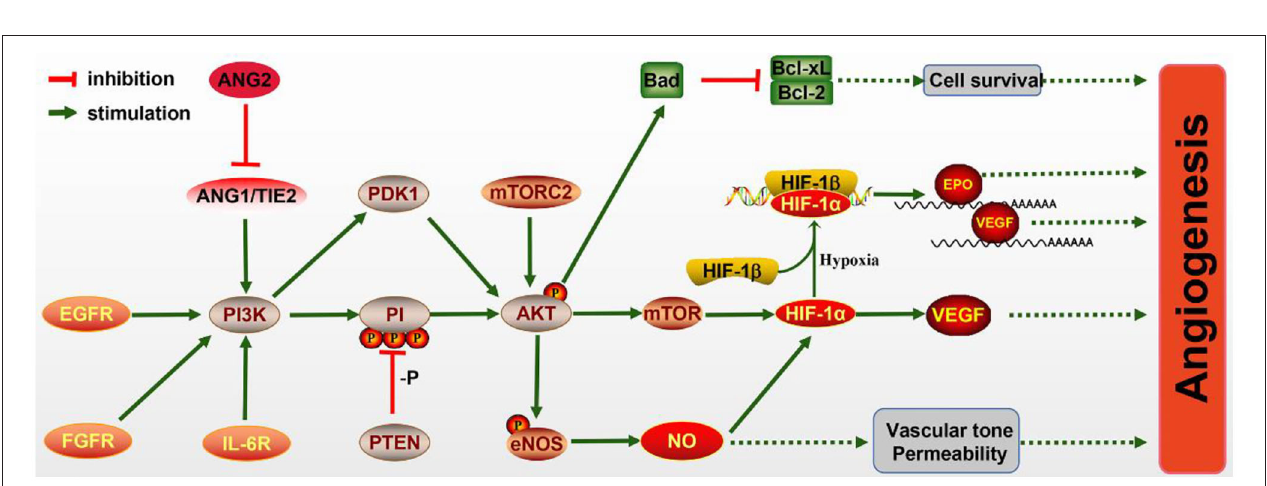
FIGURE 2 | The molecular mechanism of angiogenesis mediated by the PI3K/AKT pathway. PI3K signaling is activated by the endothelial growth factor receptor (EGFR), fibroblast growth factor receptor (FGFR), IL-6R, and Ang/Tie2 signaling molecules, leading to AKT activation. Activated AKT promotes the expression of Bad, which inhibits Bcl-CL/Bcl-2, thereby promoting the survival of pro-angiogenic cells. The mechanistic target of rapamycin (mTOR) is also activated by AKT and increases the level of HIF-1 α , which can directly increase the expression of vascular endothelial growth factor (VEGF) or bind to HIF-1 β in hypoxia conditions and transfer to the nucleus to promote the expressions of erythropoietin (EPO) and VEGF. Meanwhile, endothelial nitric oxide synthase (eNOS) activated by AKT promotes the production of NO, which protects vascular tone permeability. These potential mechanisms contribute to angiogenesis through the PI3K/AKT